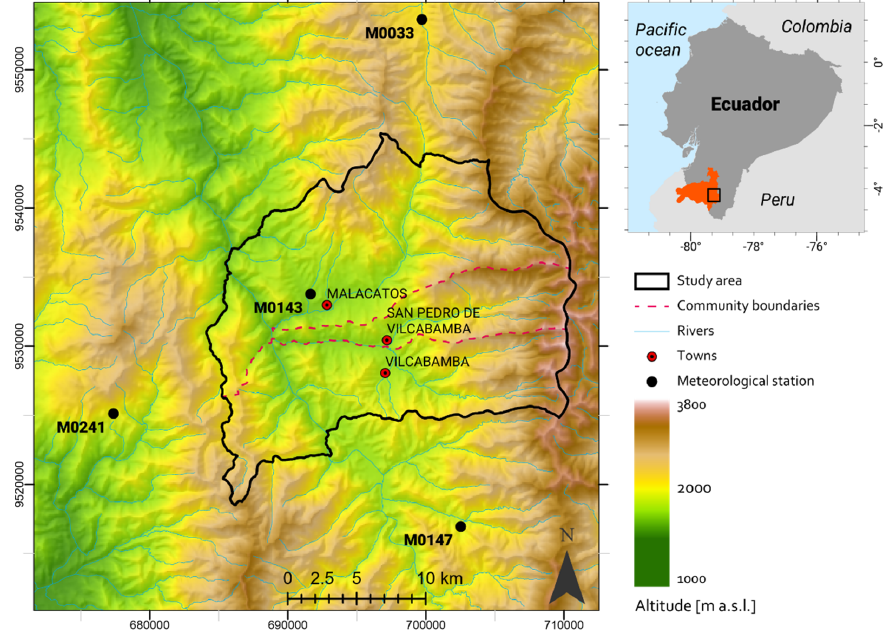
Figure 1. Digital elevation model (DEM) and limits of the communities Malacatos and Vilcabamba, including the meteorological station locations.